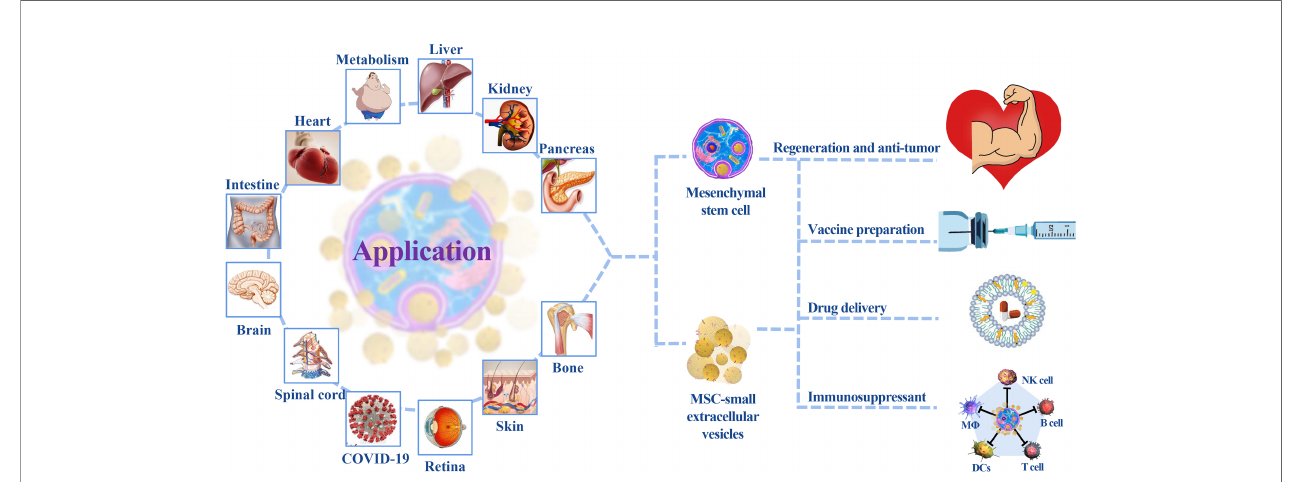
FIGURE 3 | The application of MSCs/MSC-sEVs. MSC treatment primarily focuses on regenerative repair and autoimmune disease treatment. sEVs play a key role in cardiovascular, tumor, and nervous system diseases because of their diversi fi ed administration modes and ability to cross the blood – brain barrier. Their participation in multiple-organ repair provides insight into new medical